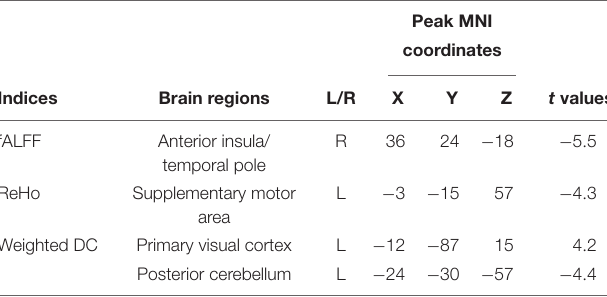
TABLE 2 | Regions with changed fALFF, ReHo, and weighted DC in RLS patients after tsDCS